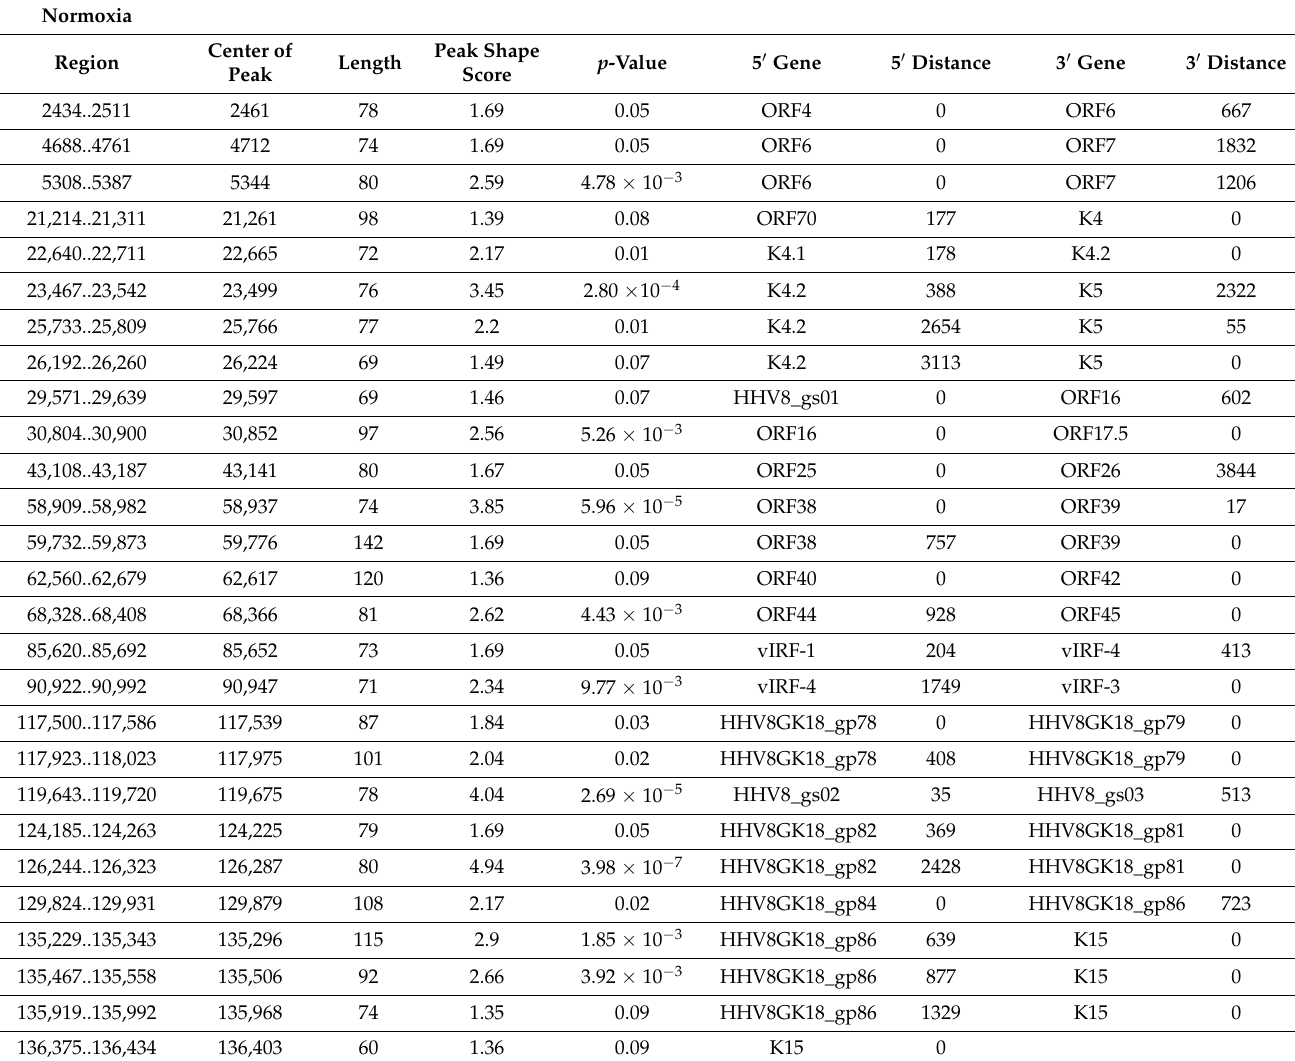
Table 2. Enrichment of DNA Polymerase 1 α on KSHV genome in normoxia. DNA Pol 1A